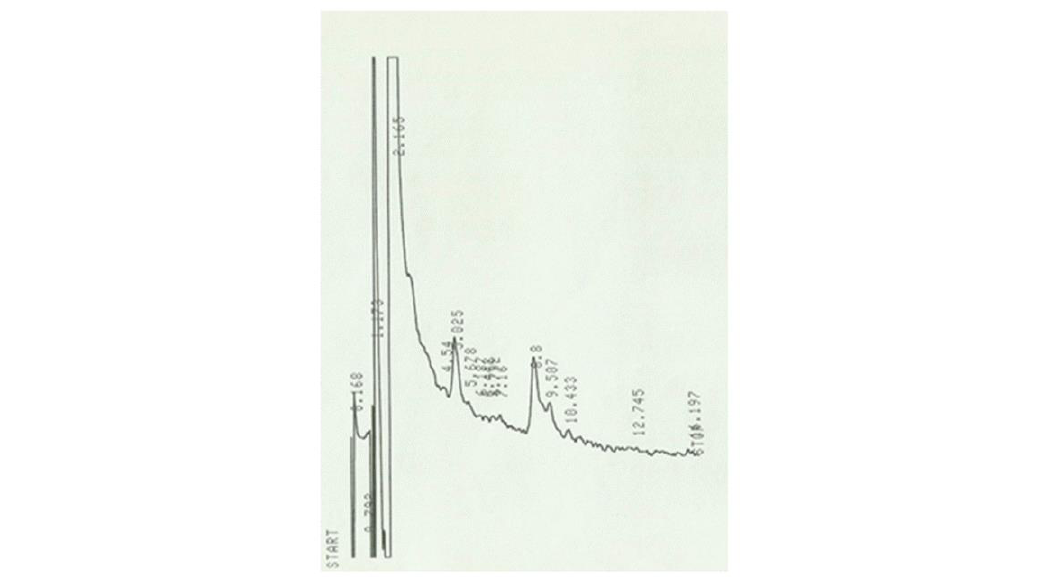
Figure 3: Chromatogram of ATRA-treated cells: HPLC-ECD of alumina-extracted media from cells treated with ATRA did not detect any dopamine, which would be expected to elute at 12 minutes.